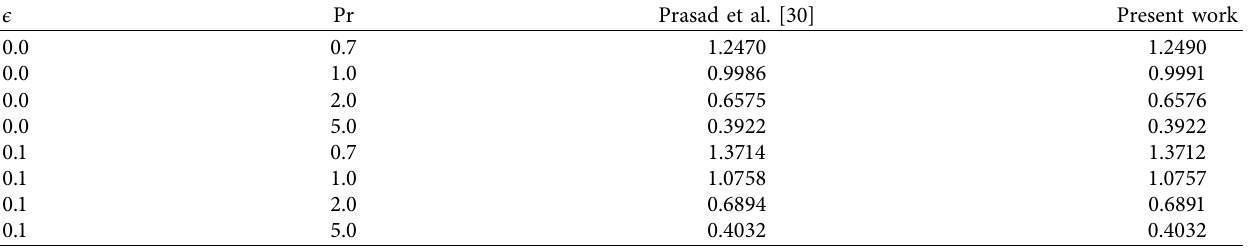
Table 1: Comparison of wall temperature θ ( 0 ) values when α � M � c � S � 0 ,r � 1 with Prasad et al. [30] (Newtonian case ( n � 1), β � 0, and ϵ � 0 . 0 , 0 . 1).